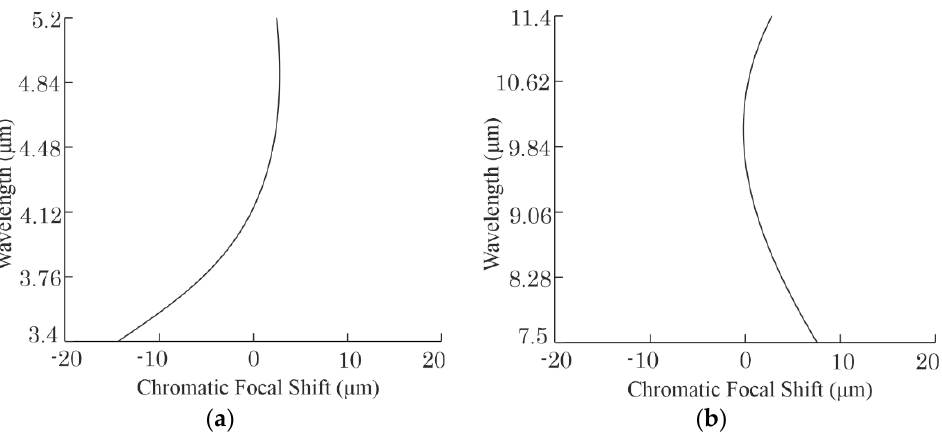
Figure 9. Chromatic focal shift for the refractive-diffractive version of the objective: ( a ), in MWIR subrange; ( b ), in LWIR subrange.